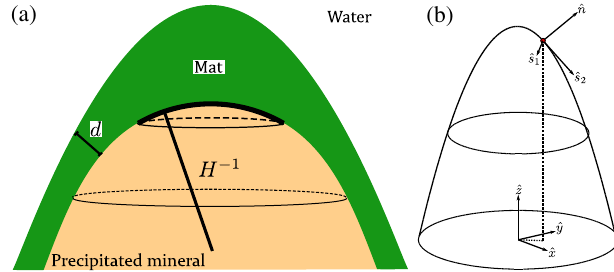
FIG. 2. A schematic of a simplified stromatolite. (a) The stro- matolite grows as chemicals diffuse through the microbial mat and precipitate at the base of the mat. The thickness d of the mat varies over the surface of the stromatolite. The shape of the interface between the microbial mat and the stromatolite is described by the local curvature H . At the tip of an axisymmetric stromatolite, H (cid:2) 1 is the radius of curvature. (b) The transforma- tion from Cartesian coordinates to the local coordinates of the surface f ð x; y Þ . The unit vectors ^ s 1 and ^ s 2 are tangent to the surface. The vector ^ n is the local normal. The position of the red circle on the stromatolite surface can be expressed in Cartesian coordinates as ½ x 0 ; y 0 ; f ð x 0 ; y 0 Þ(cid:3) or in the local coordinates as 0 Þ , where s ð s 1 ; s 2 ; 1 and s 2 are measured along the stromatolite surface from some known point. For the sake of illustration, we have shown f as a